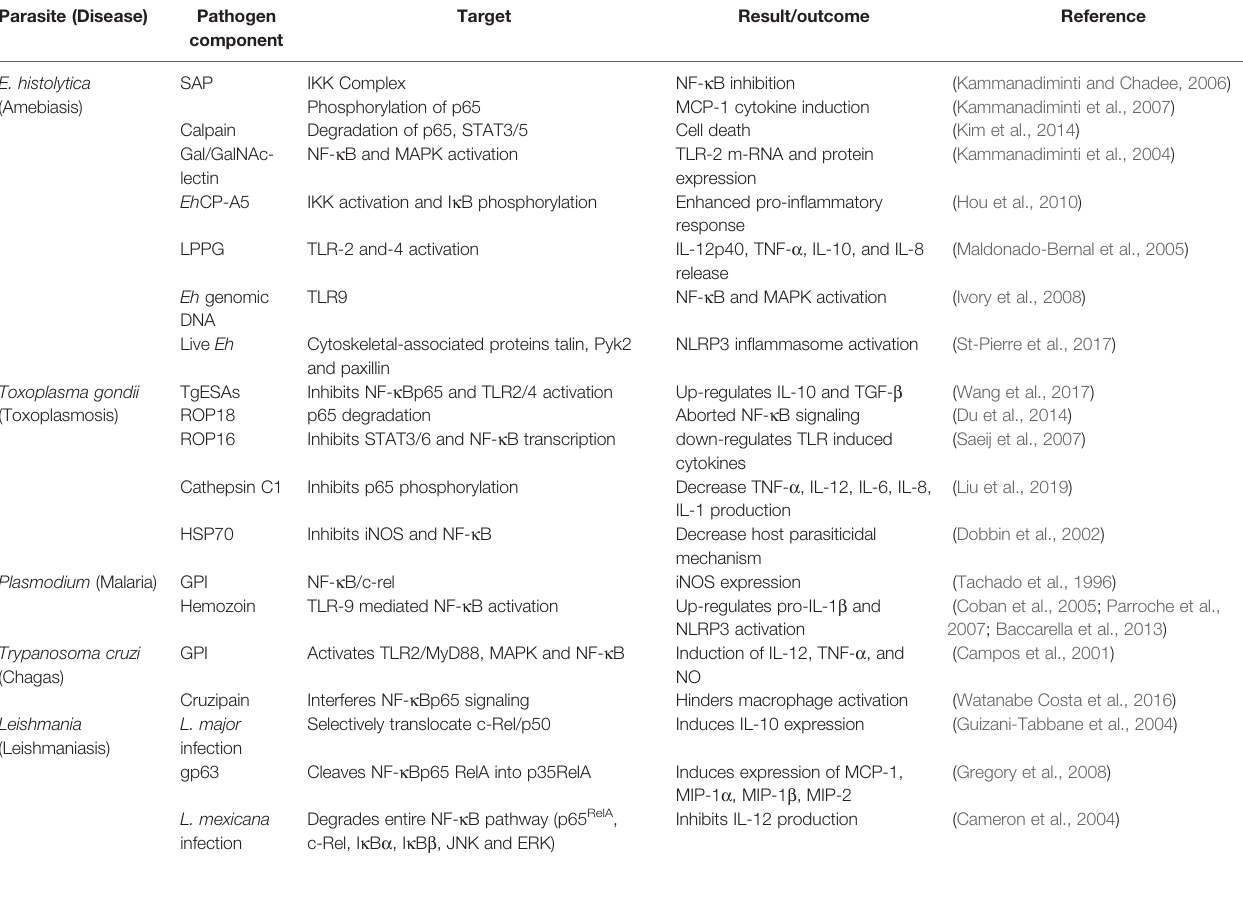
TABLE 1 | Differential regulation of the NF- k B pathway by protozoan